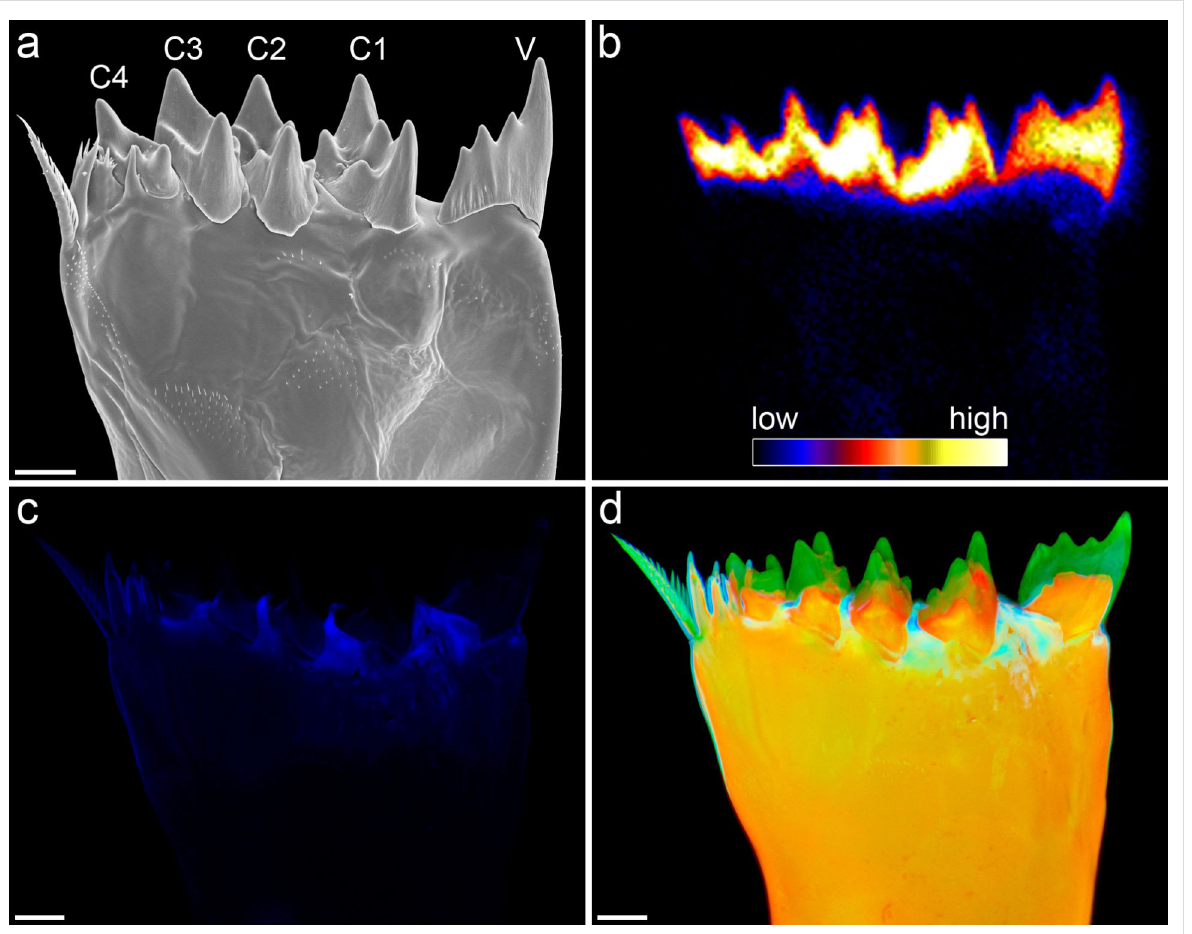
Figure 5: Mandibular gnathobases of female Rhincalanus gigas . (a) Scanning electron micrograph showing the distal part of a gnathobase (cranial view). (b) µ-PIXE mapping depicting the distribution and concentration of silicon in the distal part of a gnathobase. The orientation of the gnathobase is similar to that of the gnathobase shown in (a). (c, d) Confocal laser scanning micrographs (maximum intensity projections) showing the material composition of the distal part of a gnathobase (caudal view). (c) Distribution of resilin. (d) Chitinous exoskeleton (orange), resilin-dominated struc- tures (blue, light blue, turquoise) and silica-containing structures (green). The results indicate that the ventral tooth (V) and all central teeth (C1–C4) feature a silica-containing cap-like structure located on top of a chitinous socket. Scale bars = 25 µm. Figure adapted with permission from [33]. Copy- right 2015